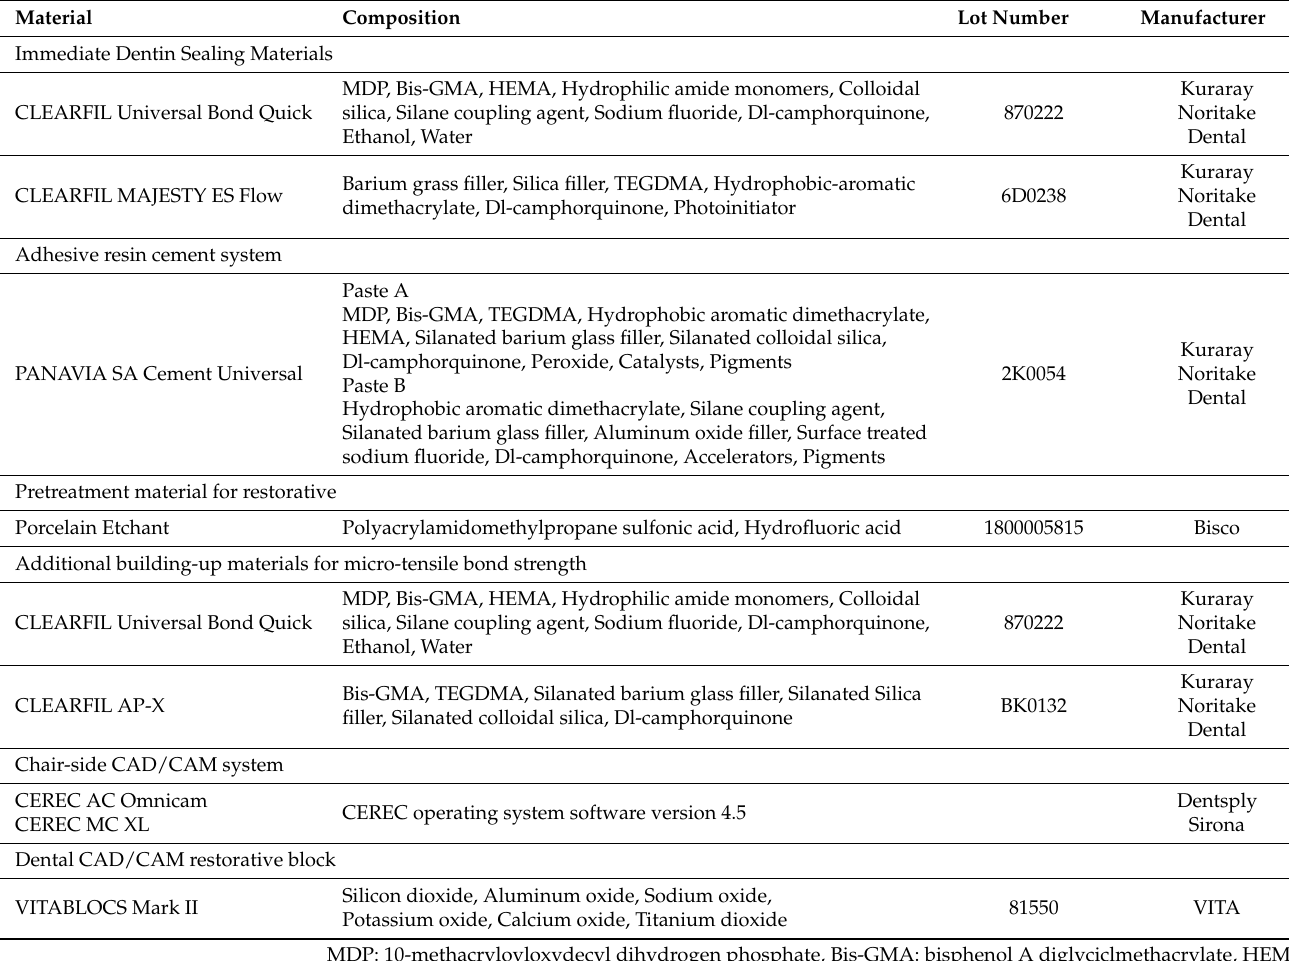
Table 1. Materials used in this